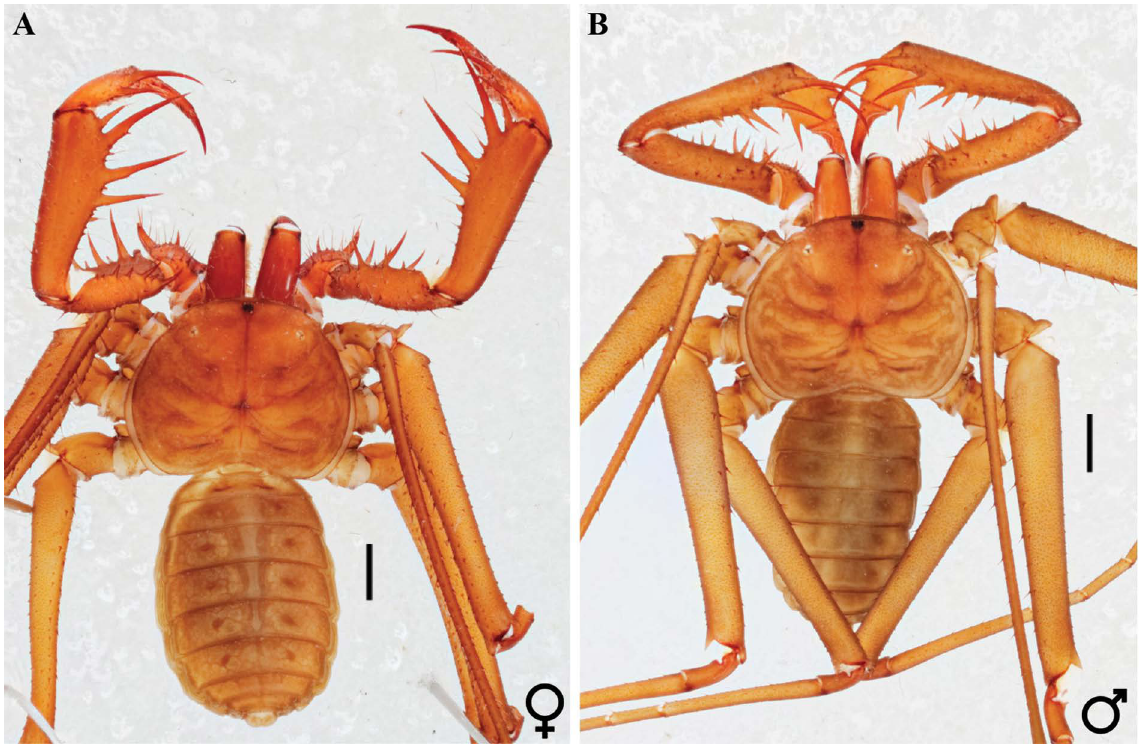
Fig. 58. Charinus diamantinus sp. nov., habitus, dorsal view illustrating secondary sexual dimorphism (males possess longer pedipalp segments than females). A . ♀ (MNRJ 9299). B . ♂ (MNRJ 9190). Scale bars: 0.1